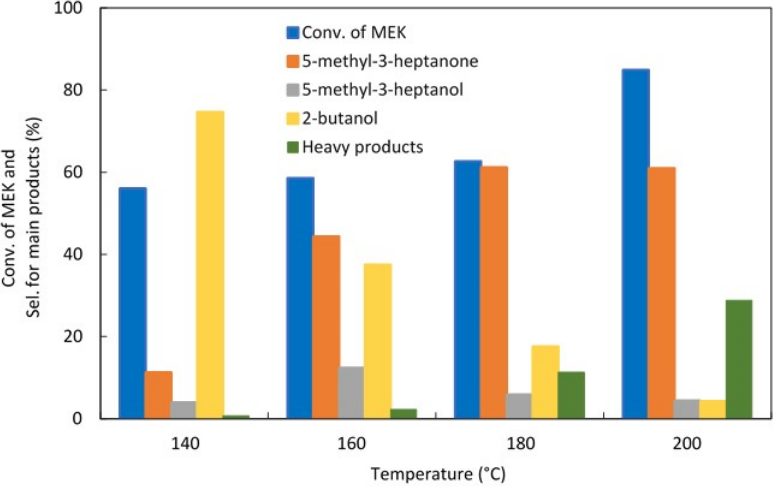
Figure 4. Catalytic results for the conversion of methyl ethyl ketone (MEK) to several products at different temperatures. Reaction conditions: catalyst weight, 1.0 g (15% Cu–ZrO 2 ); feed rate of MEK, 1.0 mL/h; H 2 /MEK molar ratio, 2; space time, 89 g mol − 1 h. Heavy products include C 12 ketone, C